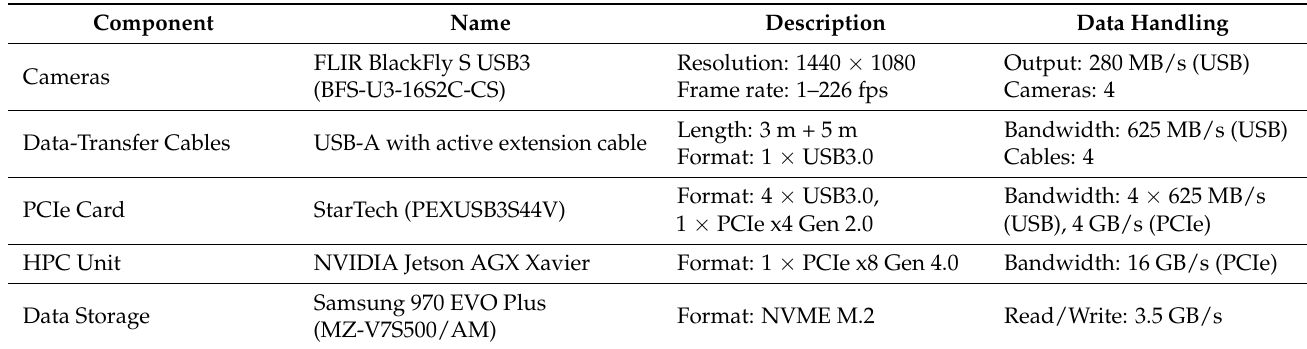
Table 2. Selected components based on computer simulations, geometric and data-transfer constraints, and desired system accuracy.